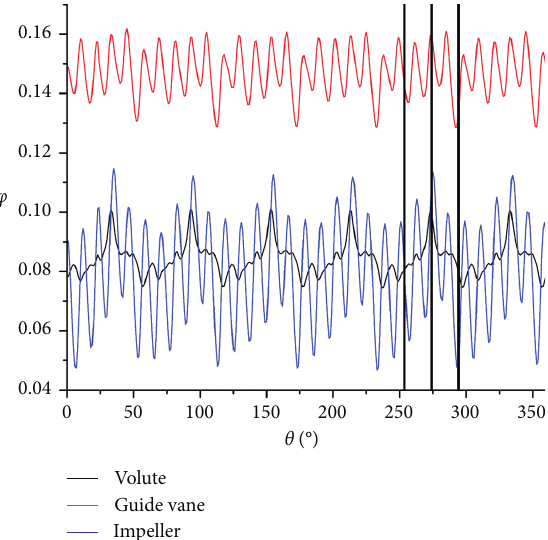
Figure 8: Energy loss of different parts inside PAT in one rotation cycle at 48m 3 /h.